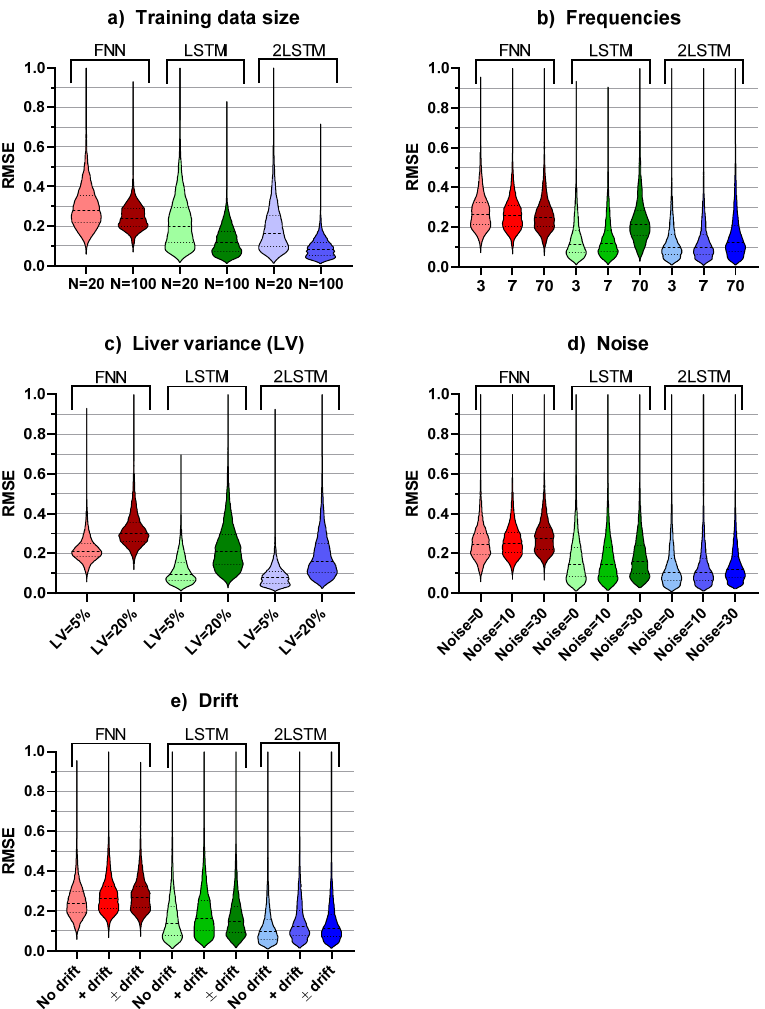
Figure 5. The distribution of prediction accuracies according to the different levels of cases included in the simulated data. The distributions are shown as violin plots with medium smoothing, where the dashed and dotted lines show the median and quartiles